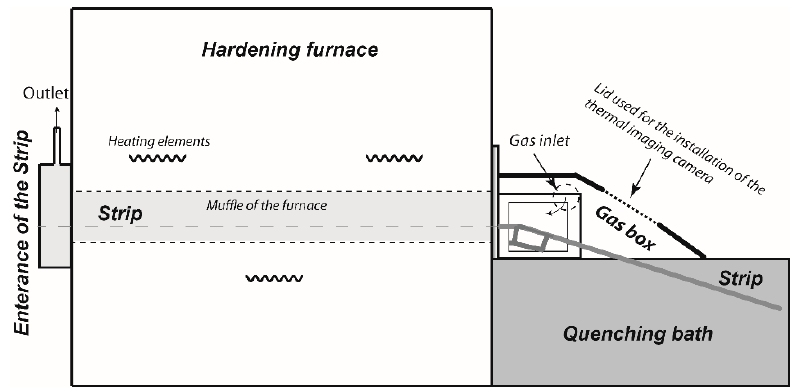
Figure 1. Schematic view of the hardening process before a martensitic phase transformation at voestalpine, Presicion Strips AB, Munkfors, Sweden.